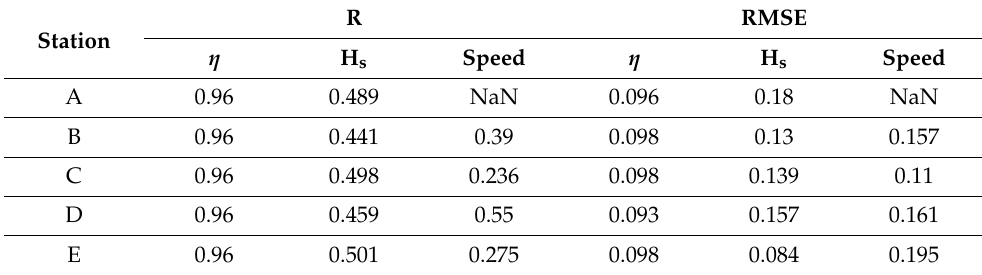
Table 1. Model performance of surface elevation, significant wave heights, and current speed for all the sensors (see the location in Figure 2a) during 21–30 November 2018.